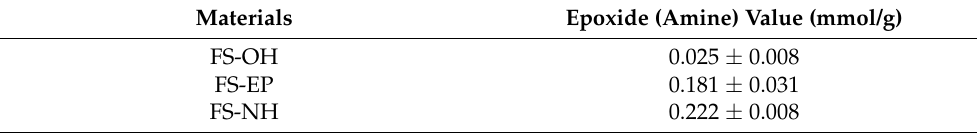
Table 3. Back titration results of silica.